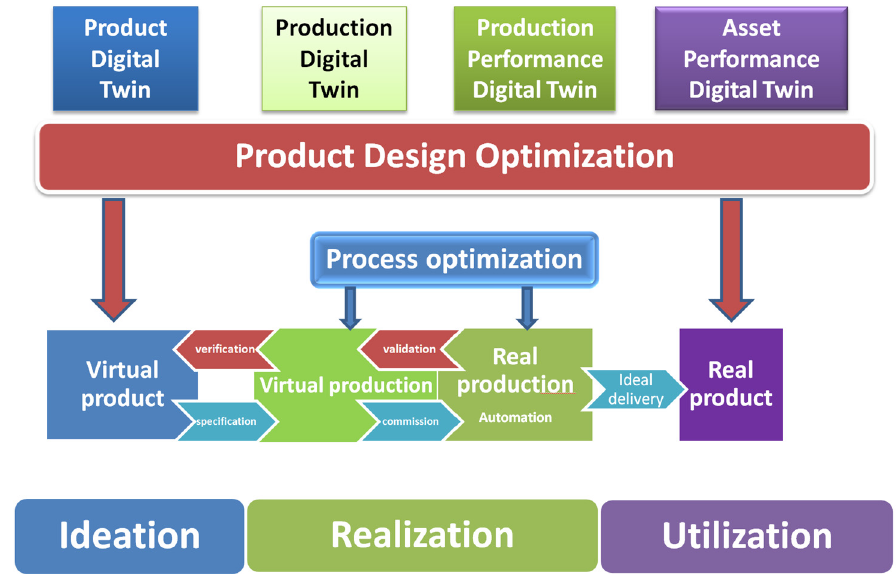
Figure 2. Virtual reality technology implemented in product design optimization.